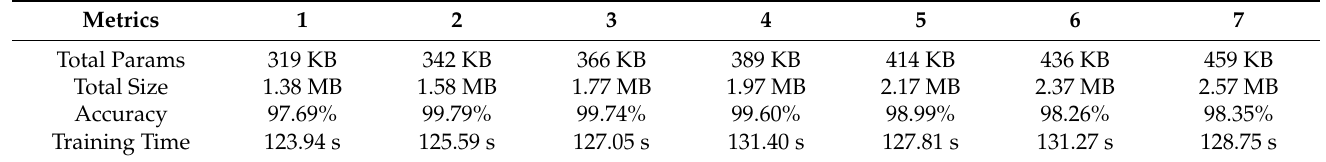
Table 5. Influence of the number of lightweight units on the performance of the proposed model.